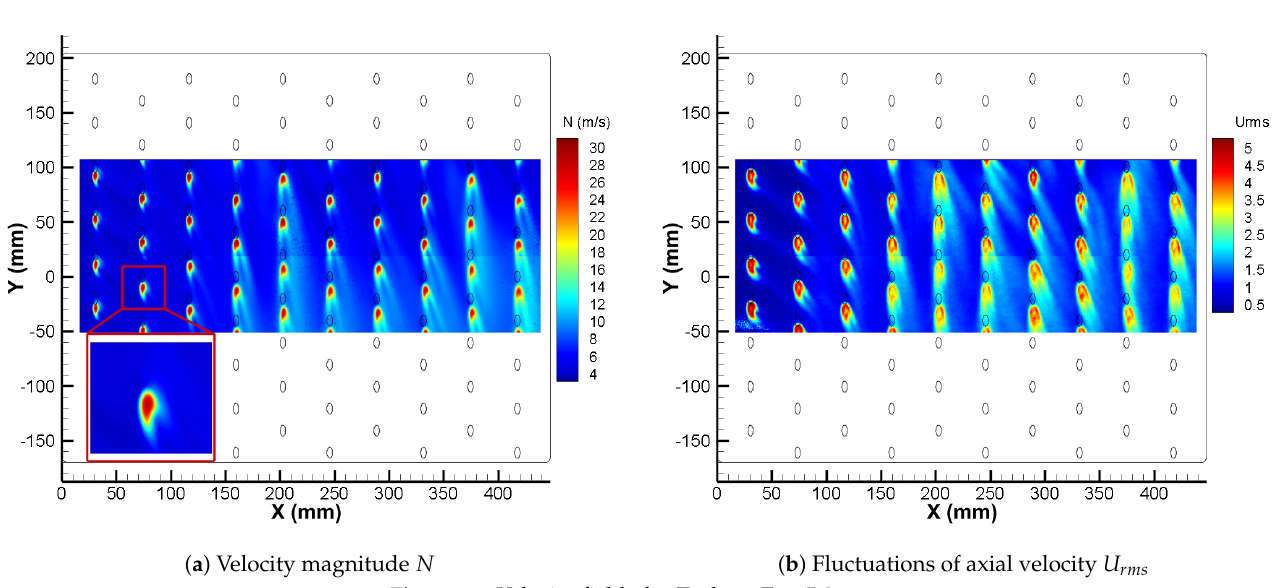
Figure 12. Velocity fields for Z-plane Z = 5.8 mm.